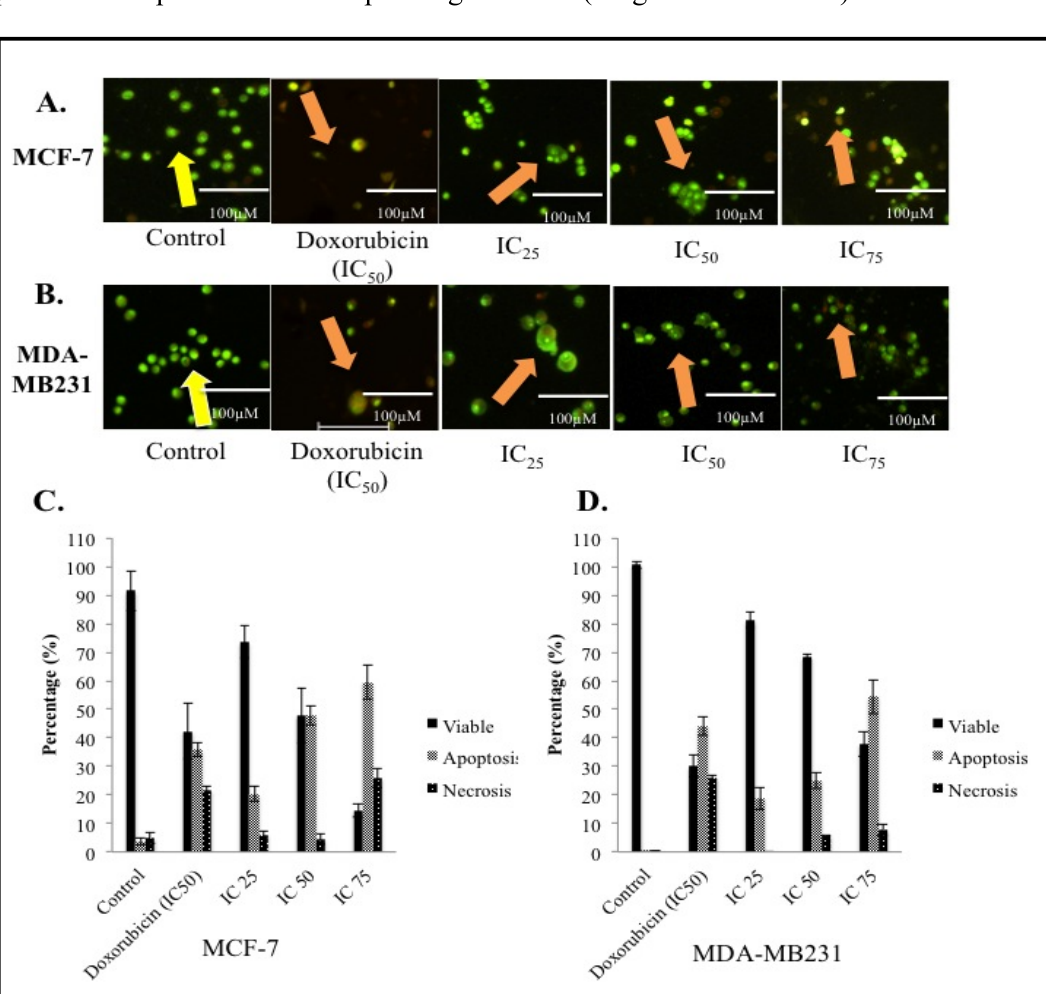
Figure 2. ( A ) Morphological changes in MCF-7 after 48 h of treatment with BHAQ (IC 25 (29.4 µM) and IC (71.2 µM)) and IC of doxorubicin (0.41 µM). (12.3 µM), IC 50 75 50 ( B ) Morphological changes in MDA-MB231 after 48 h of treatment with BHAQ (IC 25 (3.3 µM), IC (24.4 µM) and IC (92.7 µM)) and IC of doxorubicin (0.60 ± 0.36 µM). 50 75 50 ( C ) Quantification analysis of MCF-7 based on the uptake of acridine orange and propidium iodide in more than 200 cells. ( D ) Quantification analysis of MDA-MB231 based on the uptake of acridine orange and propidium iodide in more than 200 cells. (Yellow arrow: viable; orange arrow: apoptosis). All data are expressed as mean ± SD. * p < 0.05 compared with corresponding controls. (Magnification: